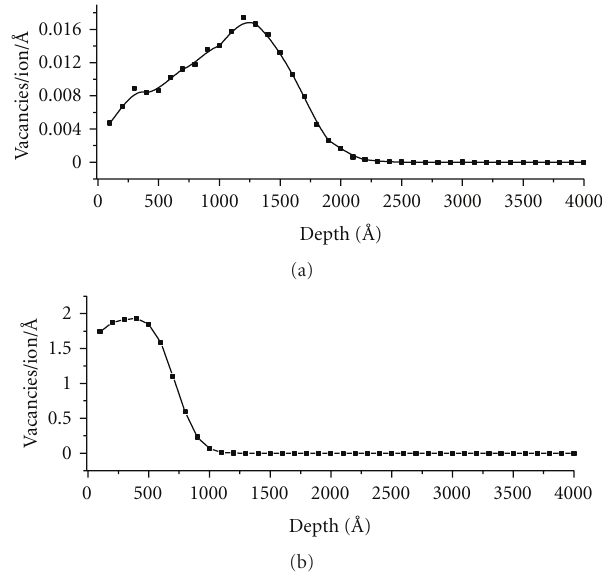
Figure 4: SRIM simulation of vacancy depth distribution under 10000 ion irradiation of (a) 20 keV He + , (b) 200 keV Xe + .